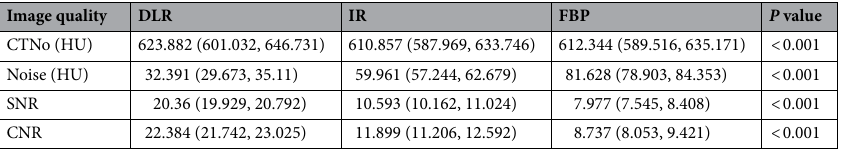
Table 1. CT image quality parameters for each reconstruction method. Data are presented as mean values with the 95% confidence interval in parentheses. DLR, deep learning-based reconstruction; IR, iterative reconstruction; FBP, filtered back projection; CTNo, mean CT attenuation values of left main and right coronary arteries; SNR, signal-to-noise ratio; CNR, contrast-to-noise ratio.